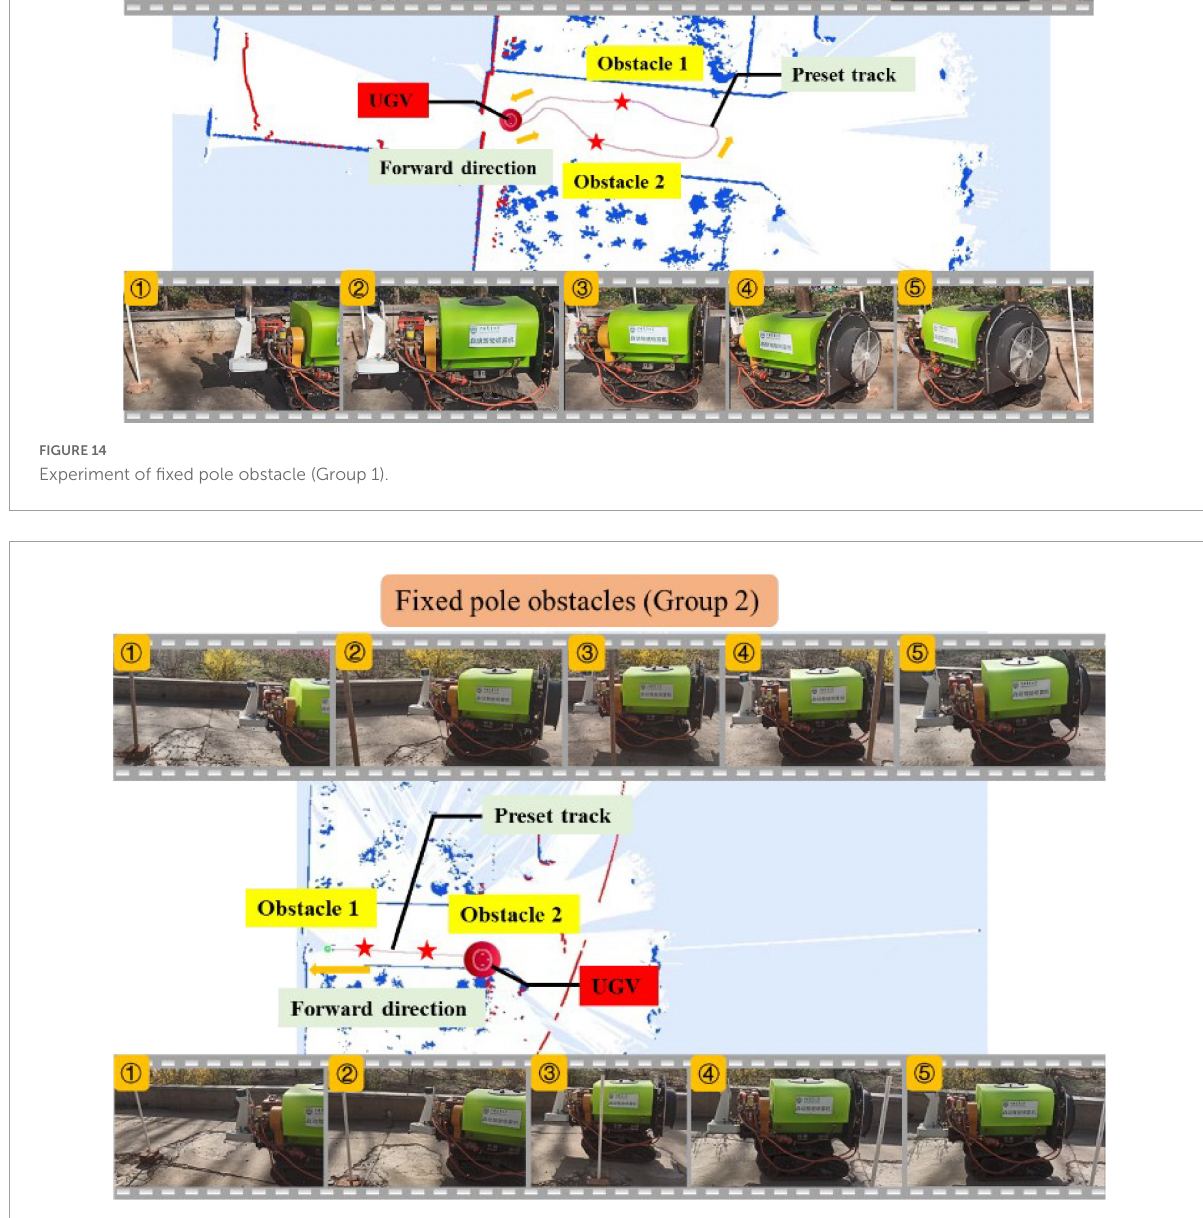
FIGURE15 Experiment of fixed pole obstacle (Group 2).